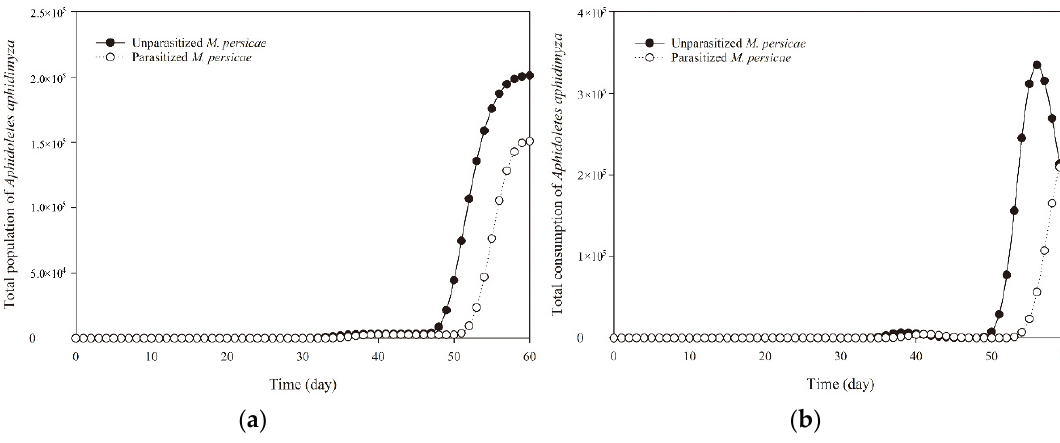
Figure 6. Total population ( a ) and total consumption ( b ) of Aphidoletes aphidimyza that fed on unparasitized and parasitized Myzus persicae by Aphidius gifuensis.